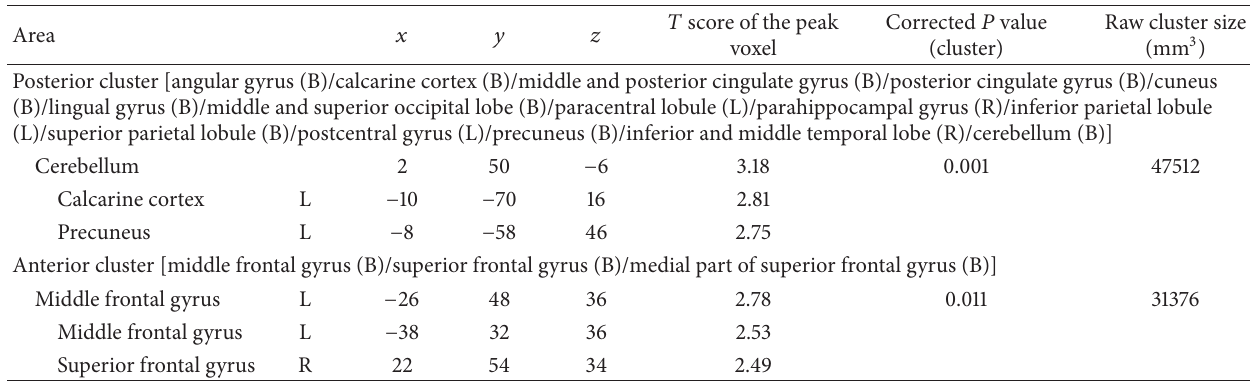
Anterior cluster [middle frontal gyrus (B)/superior frontal gyrus (B)/medial part of superior frontal gyrus (B)] Middle frontal gyrus L − 26 Middle frontal gyrus